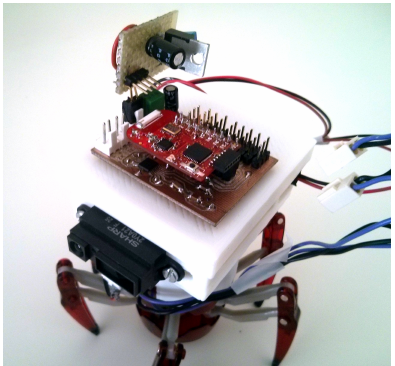
Figure 5. Node hardware structure.